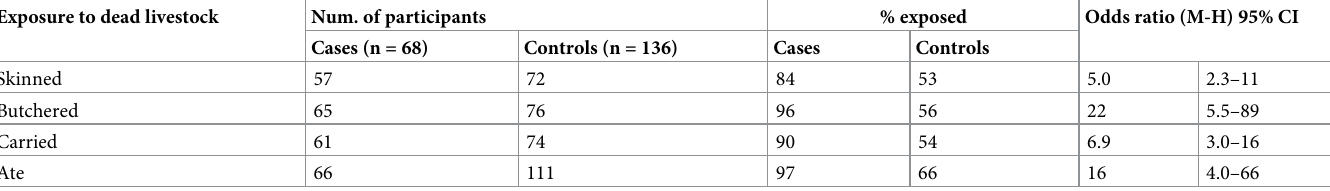
Table 2. Distribution of exposure status among cases and controls during a cutaneous anthrax outbreak. Exposure to dead